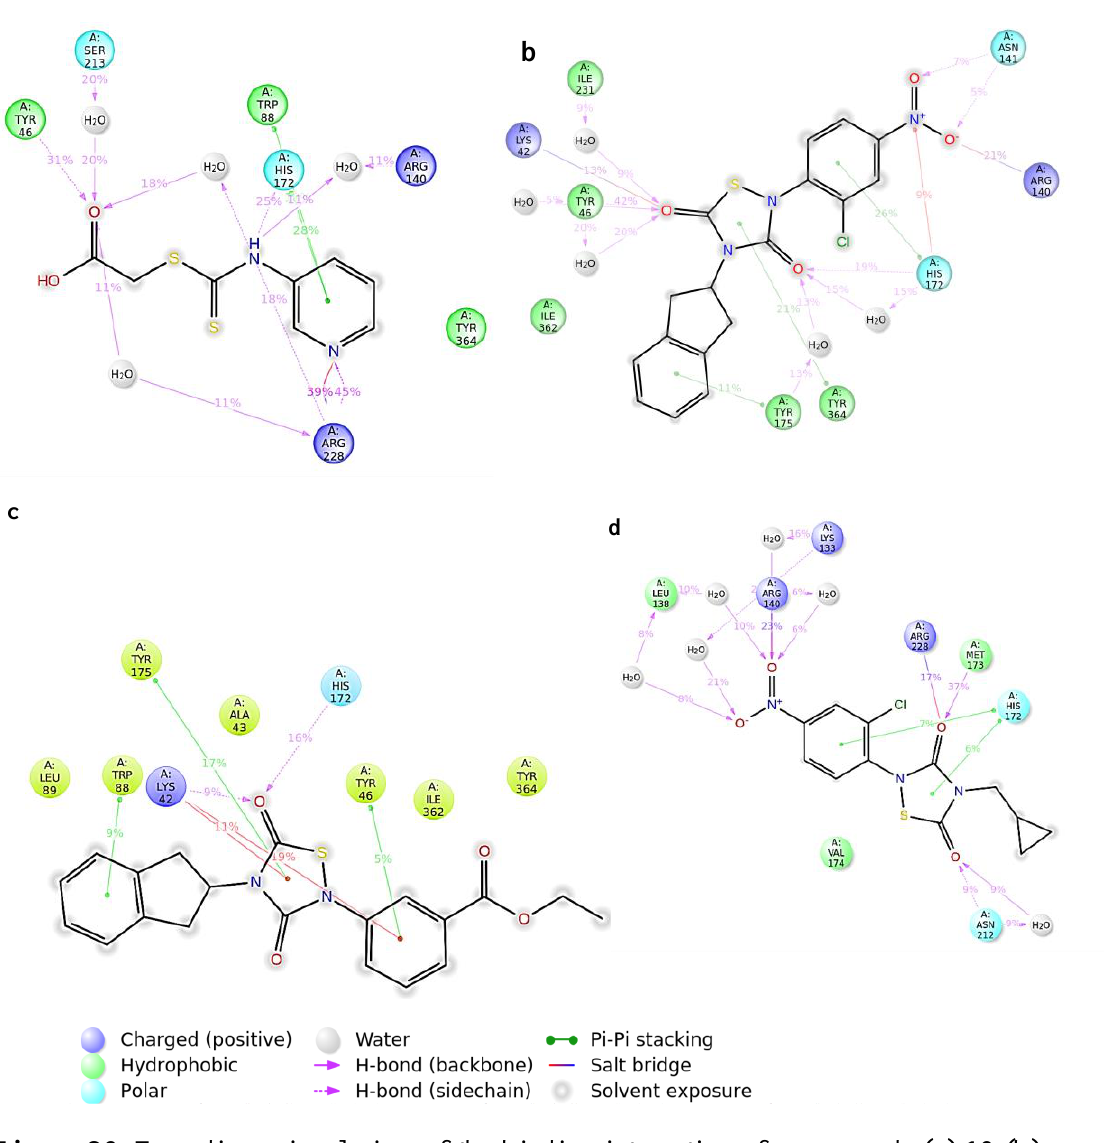
Figure S9. Two dimensional view of the binding interaction of compounds (a) 10 (b) 19 (c) 21 and (d) 25 within the Mycobacterium tuberculosis AlaR enzyme (PDB ID: 1XFC) throughout the simulation trajectory (0.00 through 10.00